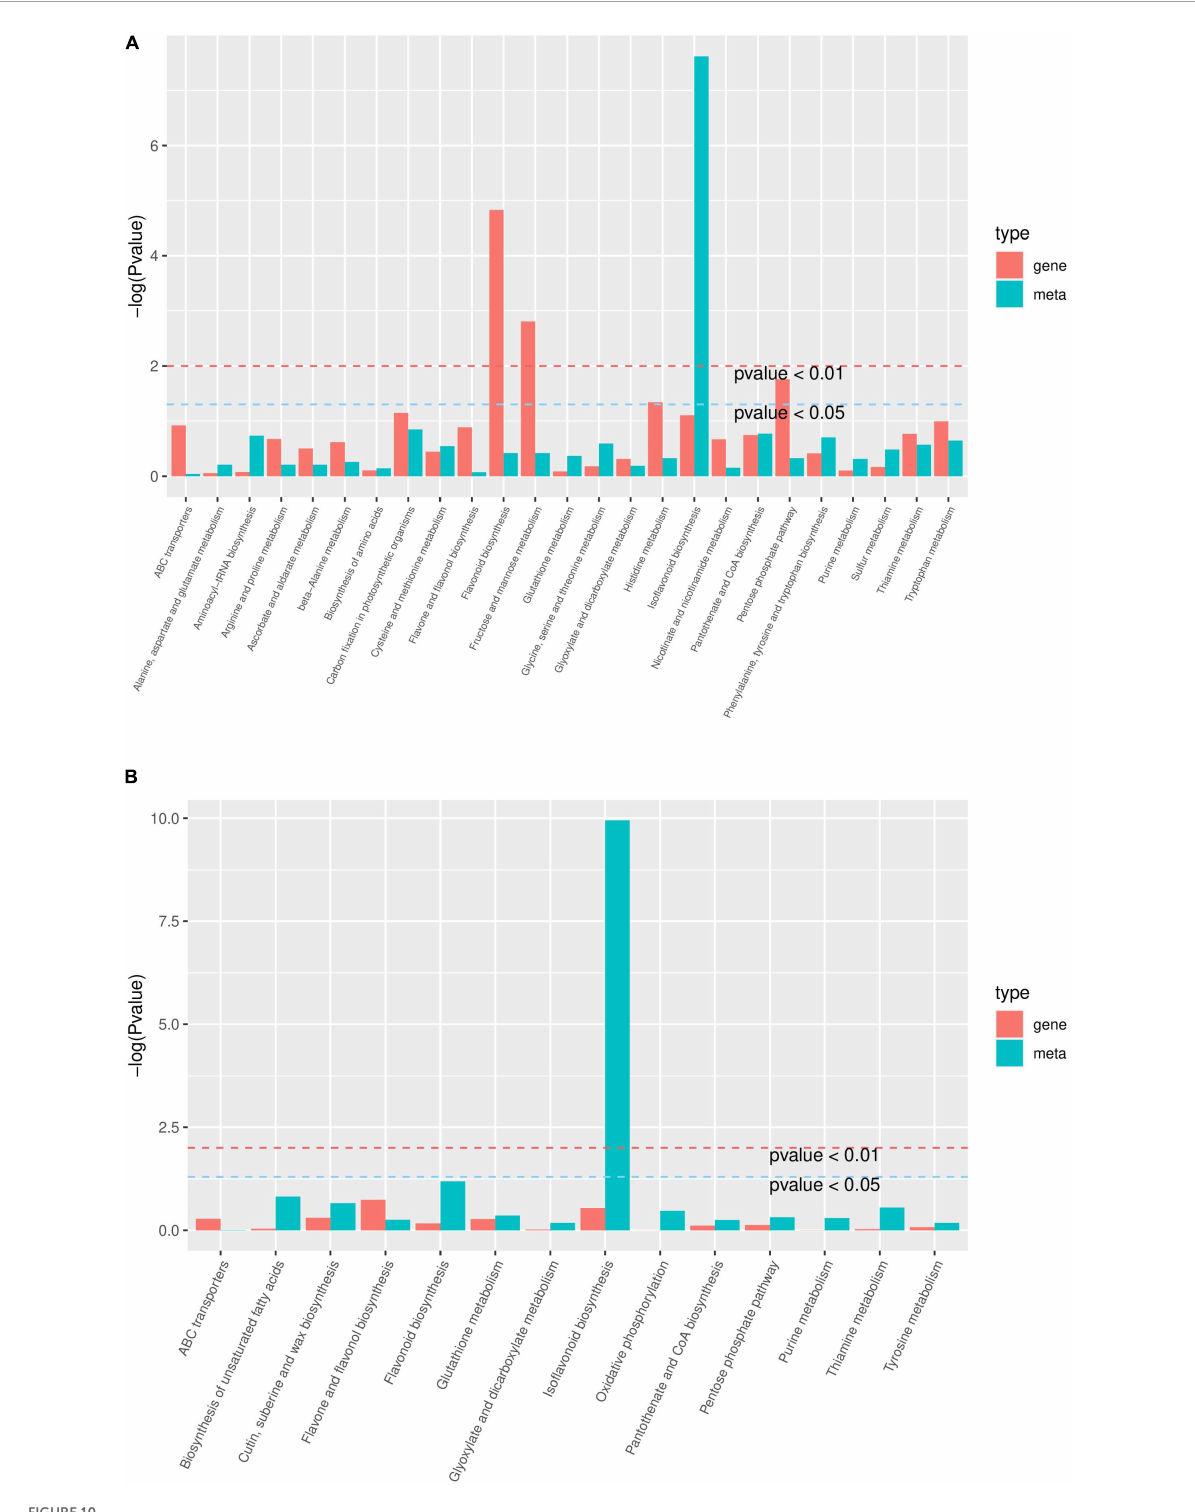
FIGURE10 KEGG enrichment analysis p -value histogram. The abscissa represents the metabolic pathway, the red in the ordinate represents the enrichment p -value of the differential metabolites, and the green represents the enrichment p -value of the differential gene, which is represented by -log ( P -value), the higher the ordinate, the higher the degree of enrichment the stronger. (A) HN44 group; (B) HN65